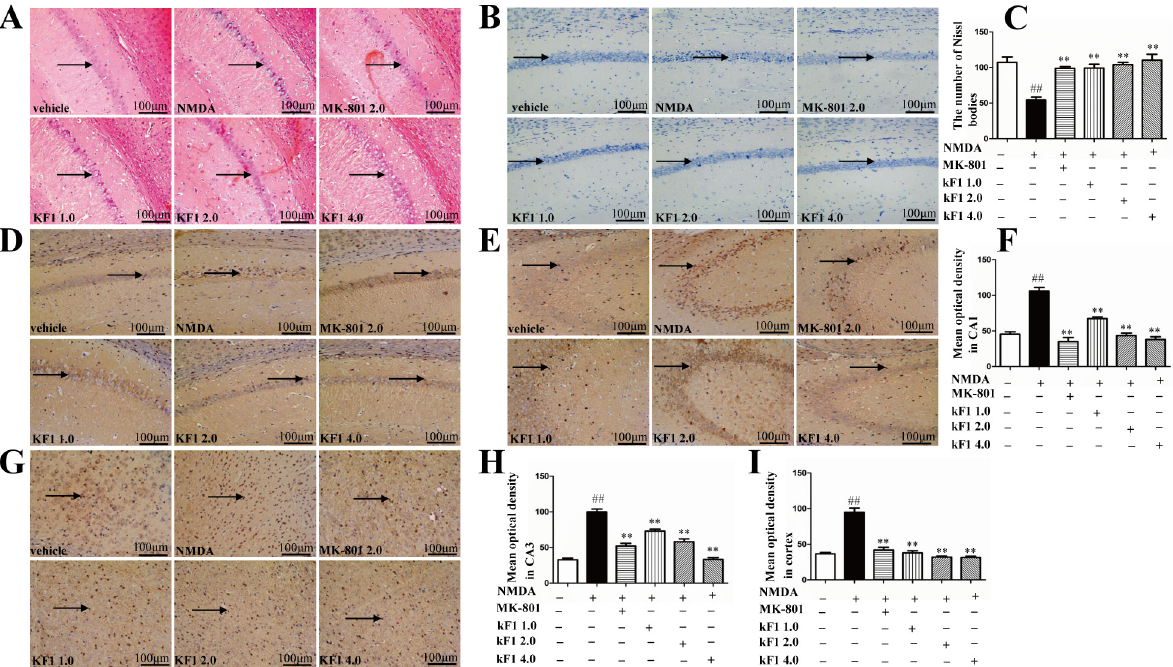
Figure 7. Histopathological changes in the mouse brain. ( A ) Hippocampus coronal paraffin sections; ( B ) representative Nissl bodies in the hippocampal; ( C ) quantitation of pyramidal cells in the hippocampal CA1; ( D ) NMDAR1 expression level in the hippocampus CA1; ( E ) NMDAR1 expression level in the hippocampus CA3; ( G ) NMDAR1 expression level in the cortex. ( F , H , I ) Immunohistochemistry mean optical density (MOD) was used to calculate NMDAR1 expression levels in each group. Bars: 100 μ m; the data represent mean ± SEM ( n = 3). ## p < 0.01 versus vehicle group; ** p < 0.01 versus NMDA group.